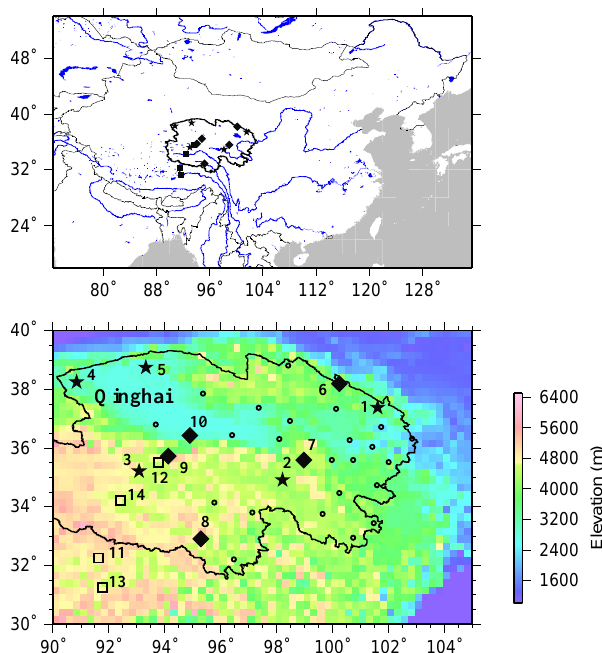
Figure 1. Geographic locations of the study domain and the sta- tions. Black lines outline the boundary of the Qinghai Province. Stars represent the stations whose observations are used to develop the linear regression relationships between daily air temperature and 0–40cm depth daily soil temperature. Stations denoted as diamonds are for monthly soil temperature evaluation and circles are for an- nual soil temperature evaluation. The stations are the following: 1: